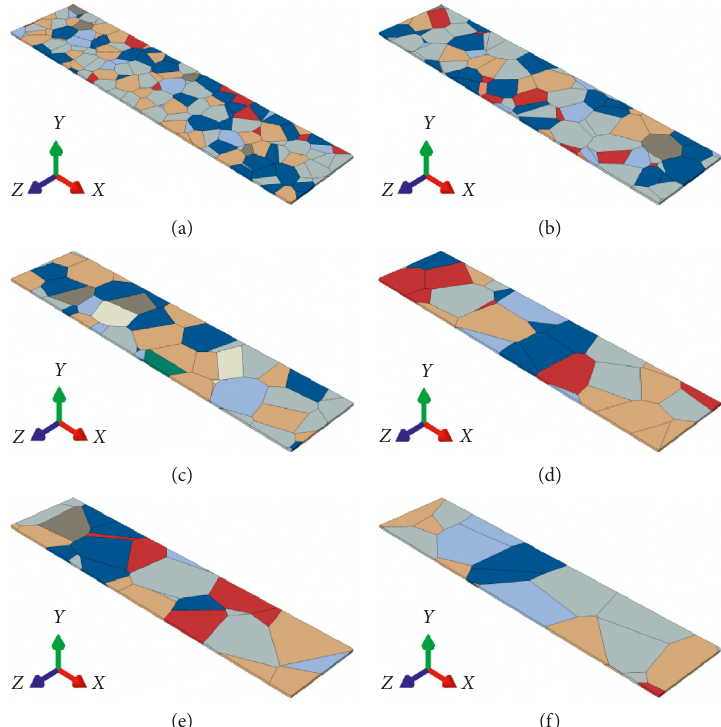
Figure 4: Overview of established 3D Voronoi tessellation in the mimicked 304 stainless steel strips: (a) S